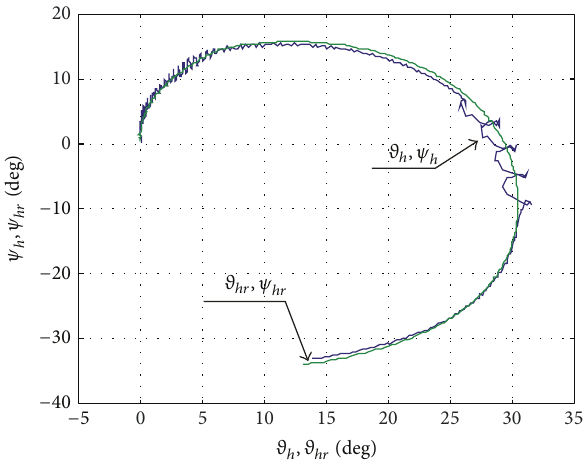
Figure 15: Real and desired trajectory of movement of the head axis for optimum controls with the influence of disturbances.